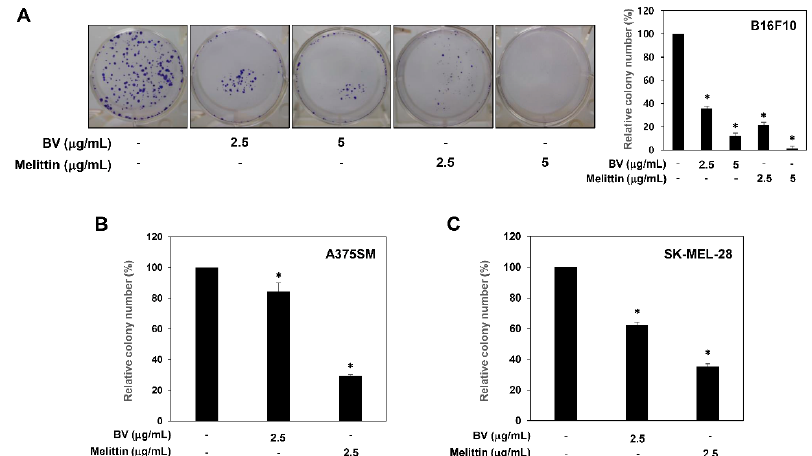
Figure 2. The effect of BV and melittin on the colony forming ability of melanoma cell lines. ( A ) B16F10, ( B ) A375SM and ( C ) SK-MEL-28 cells were treated with BV and melittin for 8–10 days. The cell colonies were detected by crystal violet staining and then counted. * p < 0.05 versus the control. Each value represents the mean ± SE from three independent experiments.